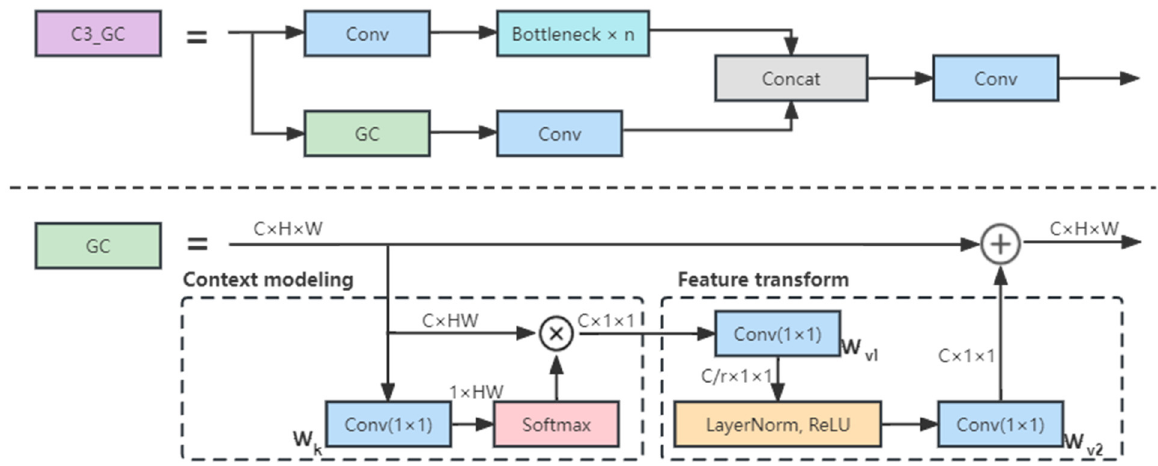
Figure 4. Structure diagram of C3_GC and GC block.